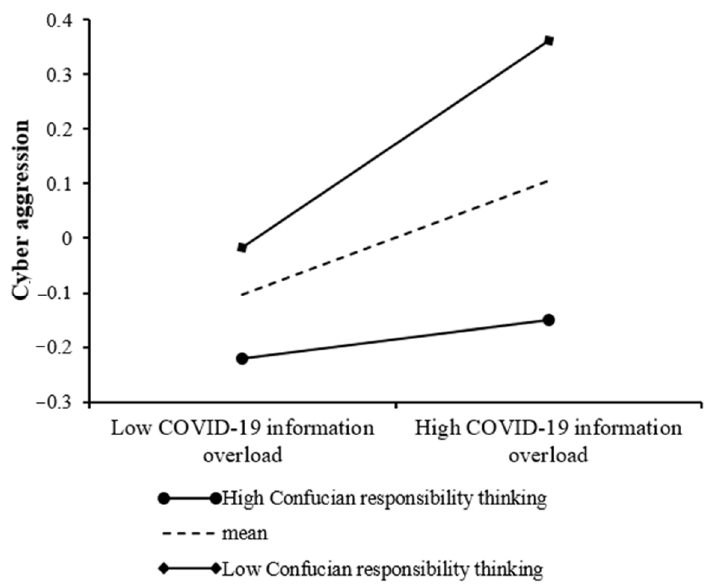
Figure 4. Confucian responsibility thinking moderates the direct effect of COVID-19 information overload on cyber aggression.